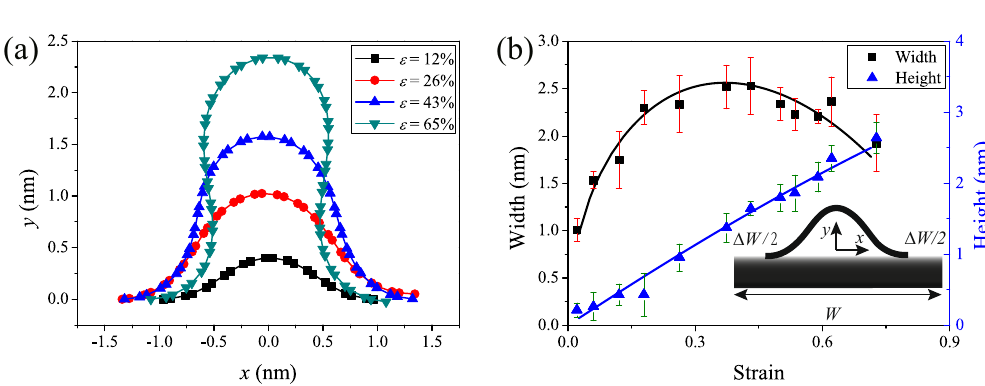
Figure 2. MD simulation models and calculated results, T = 300 K. ( a ) The MD simulation model is a stack of two rectangular materials, upper cyan graphene and lower red copper. ( b ) After the pre-compression being released, a typical graphene wrinkle is clearly formed on copper substrate. ( c ) Simulation results of graphene wrinkles vesus strain, for small strain, both h and W increase with strain; for large strain, h still increases with strain, however, W surprisingly decreses with strain. The error bars represent the standard deviation of five independent calculations.